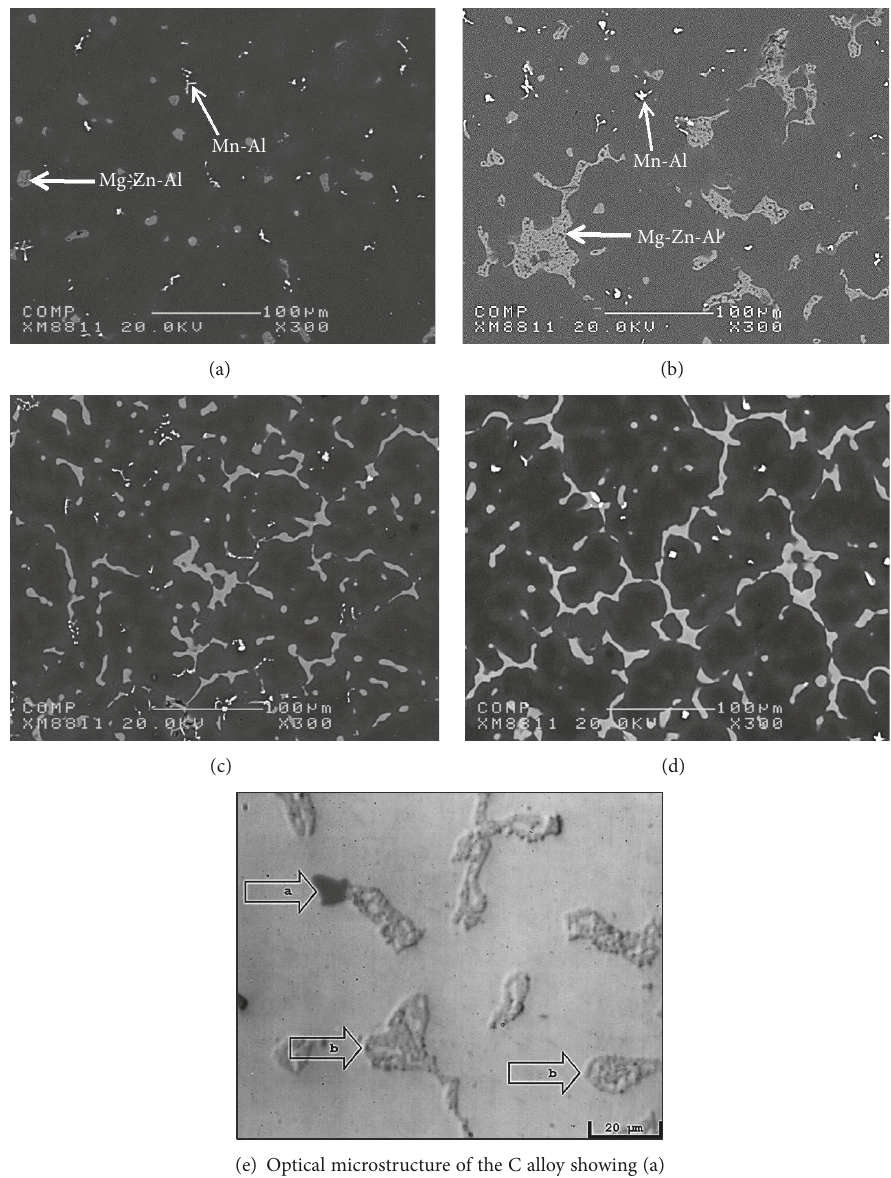
Figure 2: Backscattered electron images showing the size and distribution of the Mg-Al-Zn phase in: (a) A alloy, 4wt% Al; (b) C alloy, 9 wt% Al; (c) D alloy, 11wt% Al; (d) E alloy, 14wt% Al. Note: white particles are Mn-Al phase and gray particles are Mg-Al-Zn